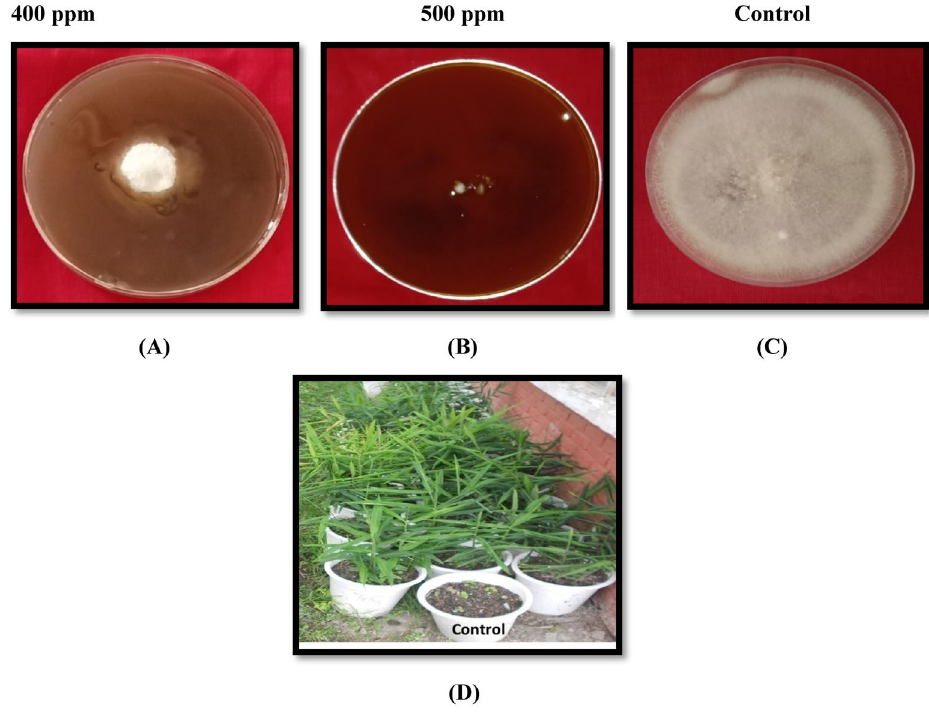
Figure 8. ( A – C ) In vitro evaluation and ( D ) In vivo evaluation of antifungal activity of NAFO nanoparticles under pot conditions.